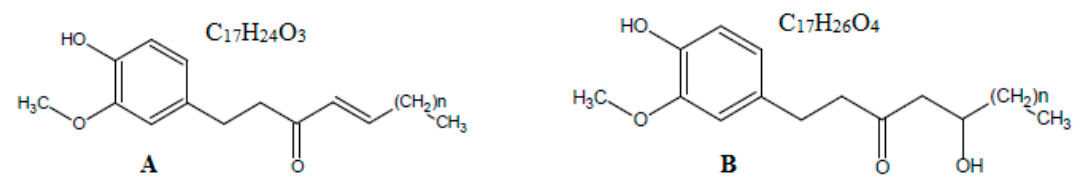
Figure 1. Chemical structure of ( A ) 6-shogaol (6-SHO) and ( B ) 6-gingerol (6-GIN).